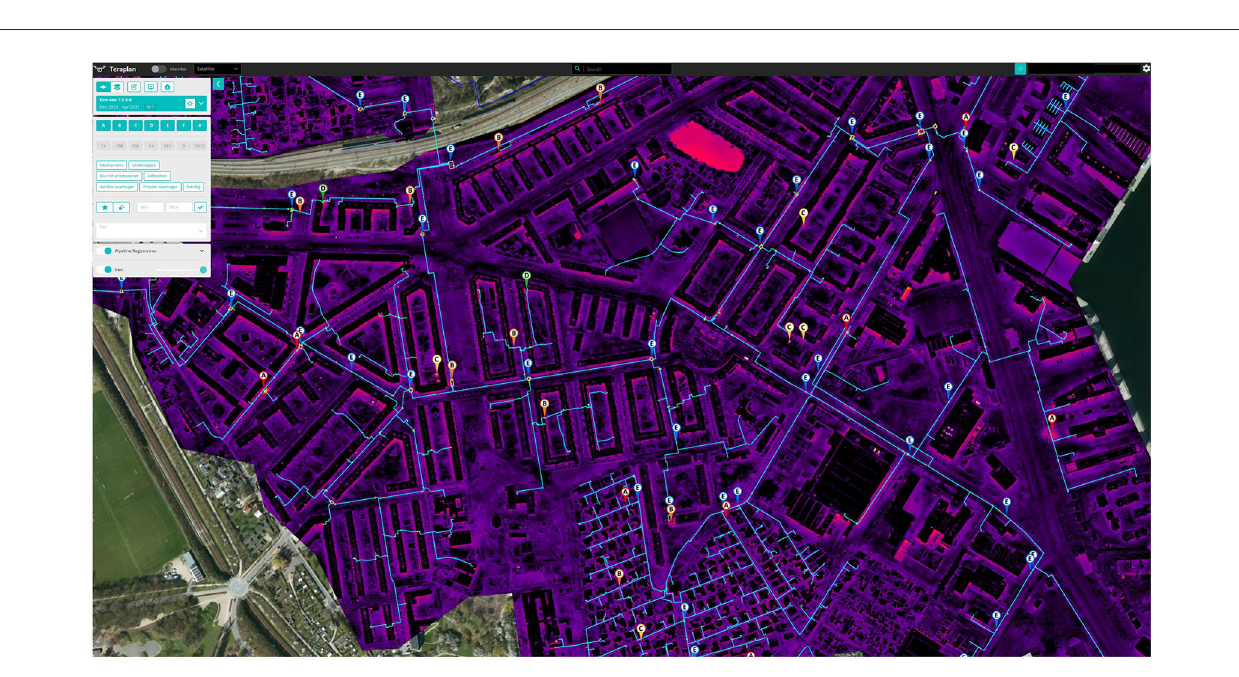
FIGURE4 Screenshot of